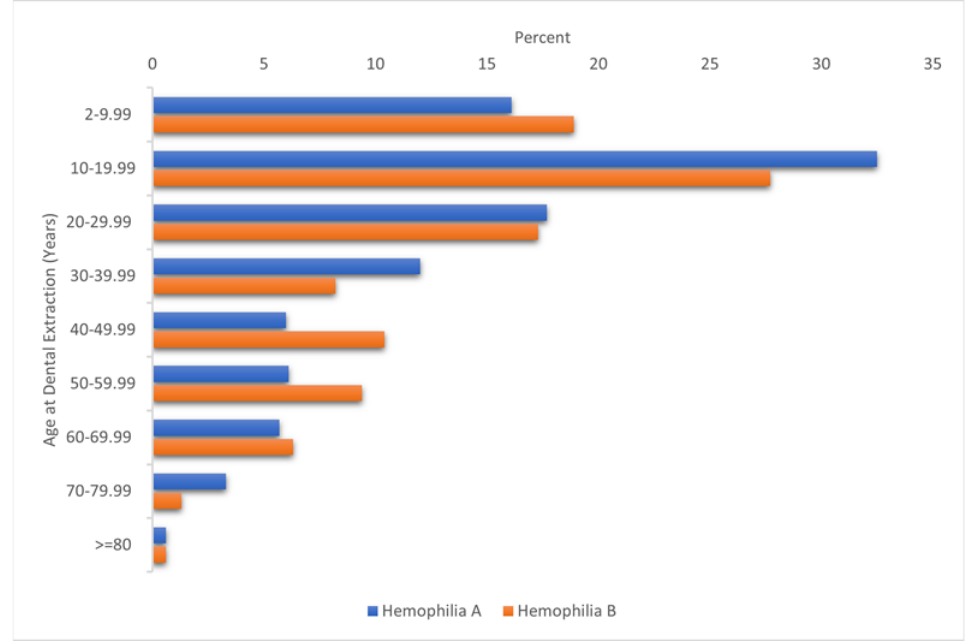
Figure 1 . The distribution of age at dental extraction among hemophilia patients, 2013 – 2019 . Figure 1. The distribution of age at dental extraction among hemophilia patients,